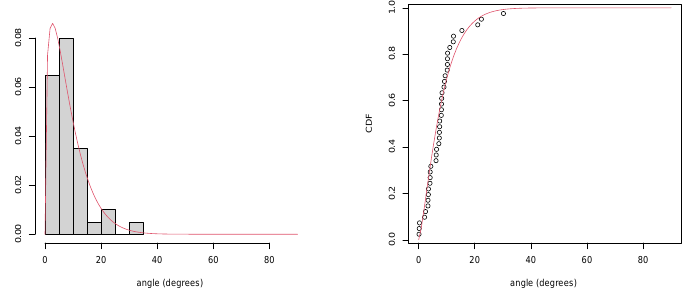
Figure 10. Inferential statistics on the population of tilt angles: the estimated density function in the range 0–90 degrees ( left ) and the cumulative distribution function ( right